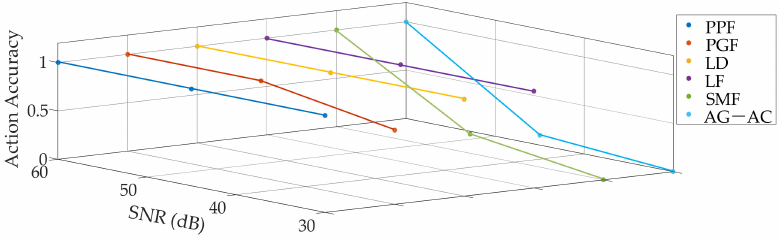
Figure 19. The influence of signal-to-noise (SNR) on the action